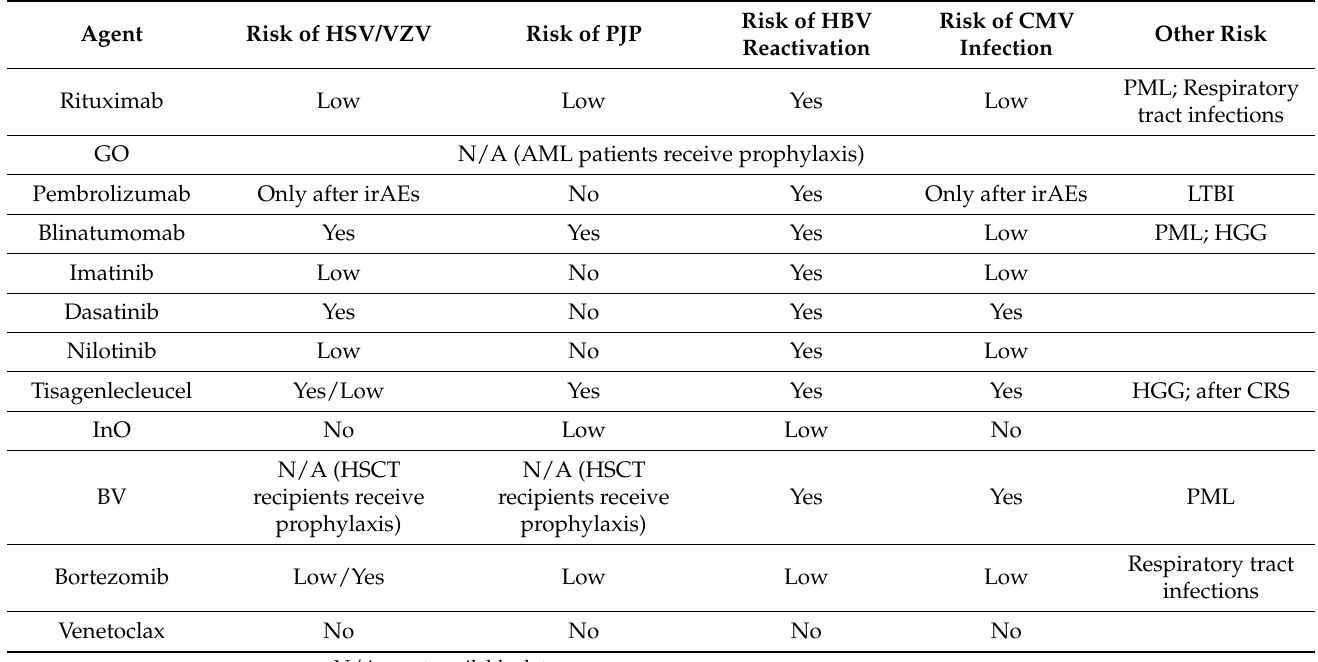
Table 4. Risk of specific infectious complications and suggested prevention